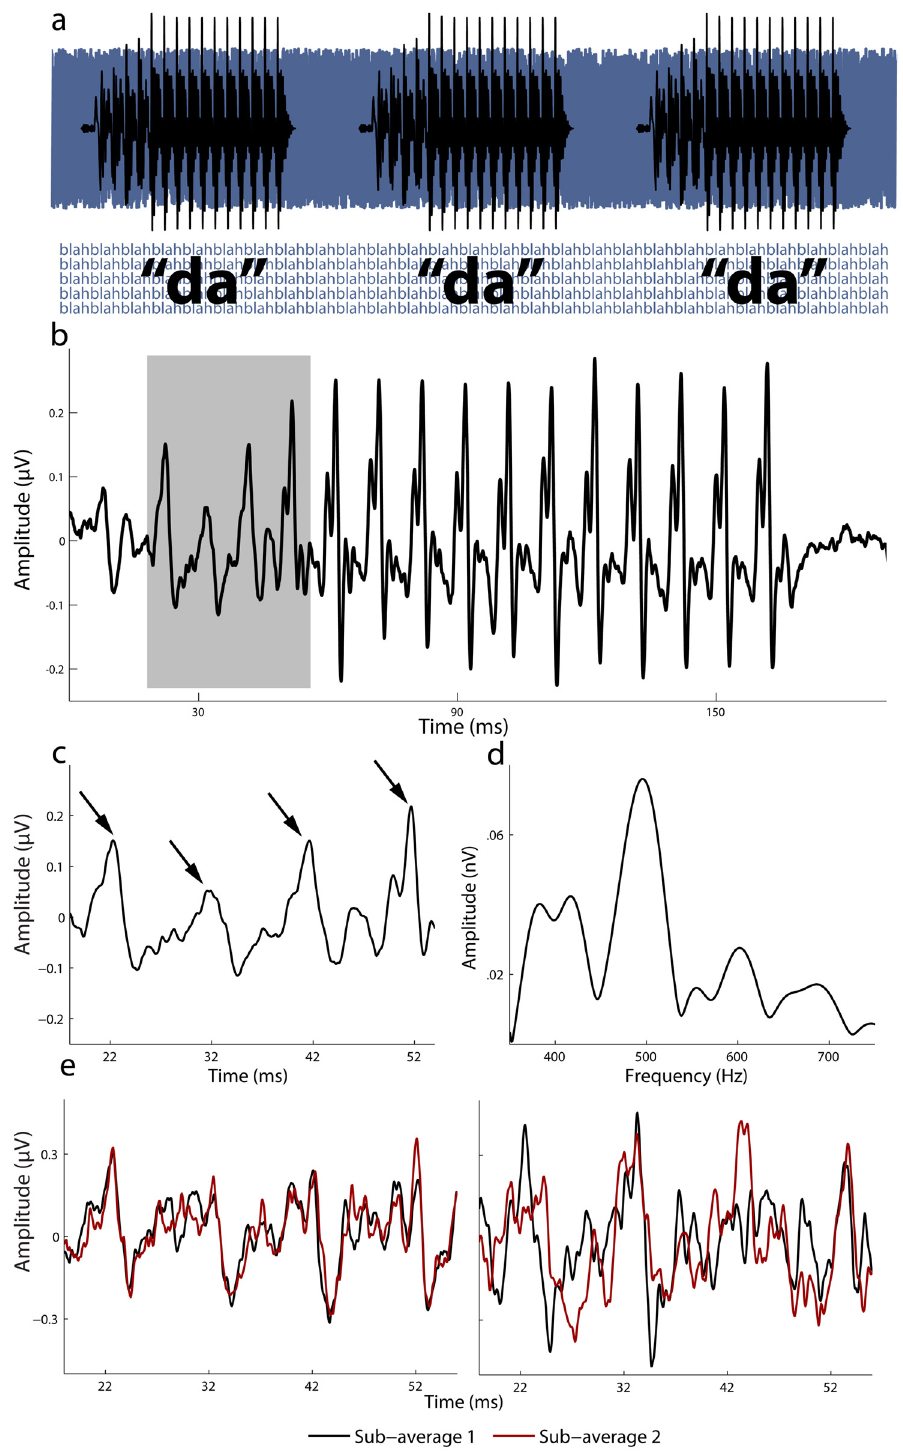
Fig 1. Overview of the auditory-neurophysiological biomarker and three derived neural measures. (A) Recording paradigm: [da] is presented repeatedly over a continuous background track of nonsense sentences spoken by multiple talkers. (B) A time-domain average waveform of the response. The response shows many of the physical characteristics of the eliciting stimulus. The gray box highlights the time region of the response that corresponds to the consonant transition (the region of interest). (C) The peaks of